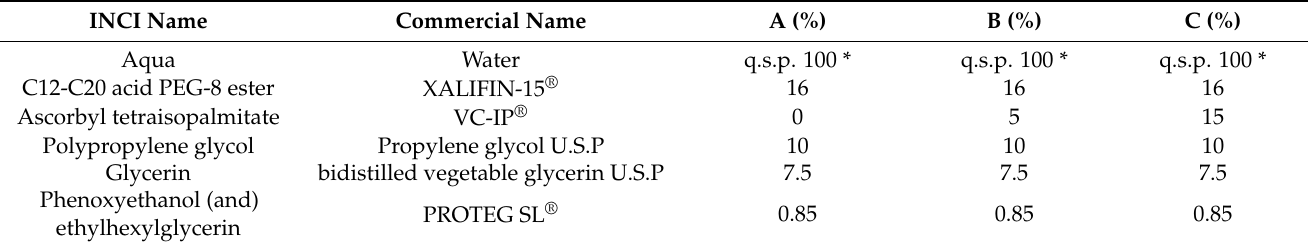
Table 1. Composition of the developed cosmetic formulations and their respective